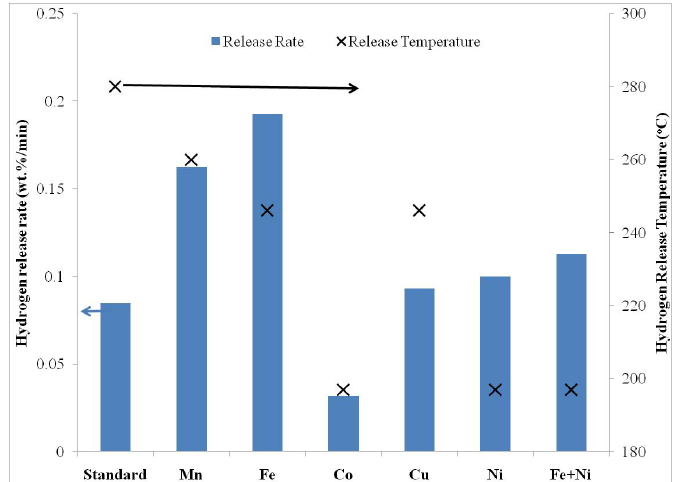
without and with 2 mol%, 2